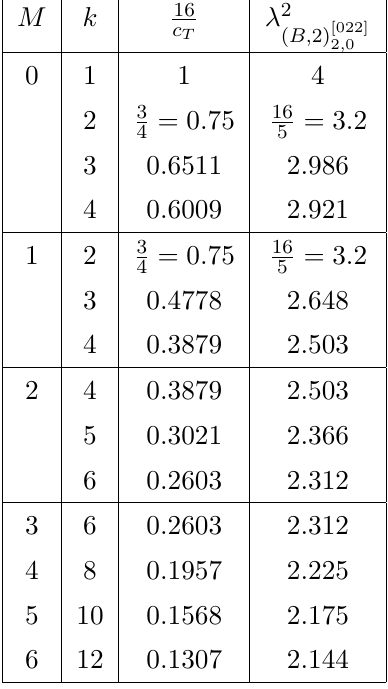
Table 11 . OPE coefficients 16